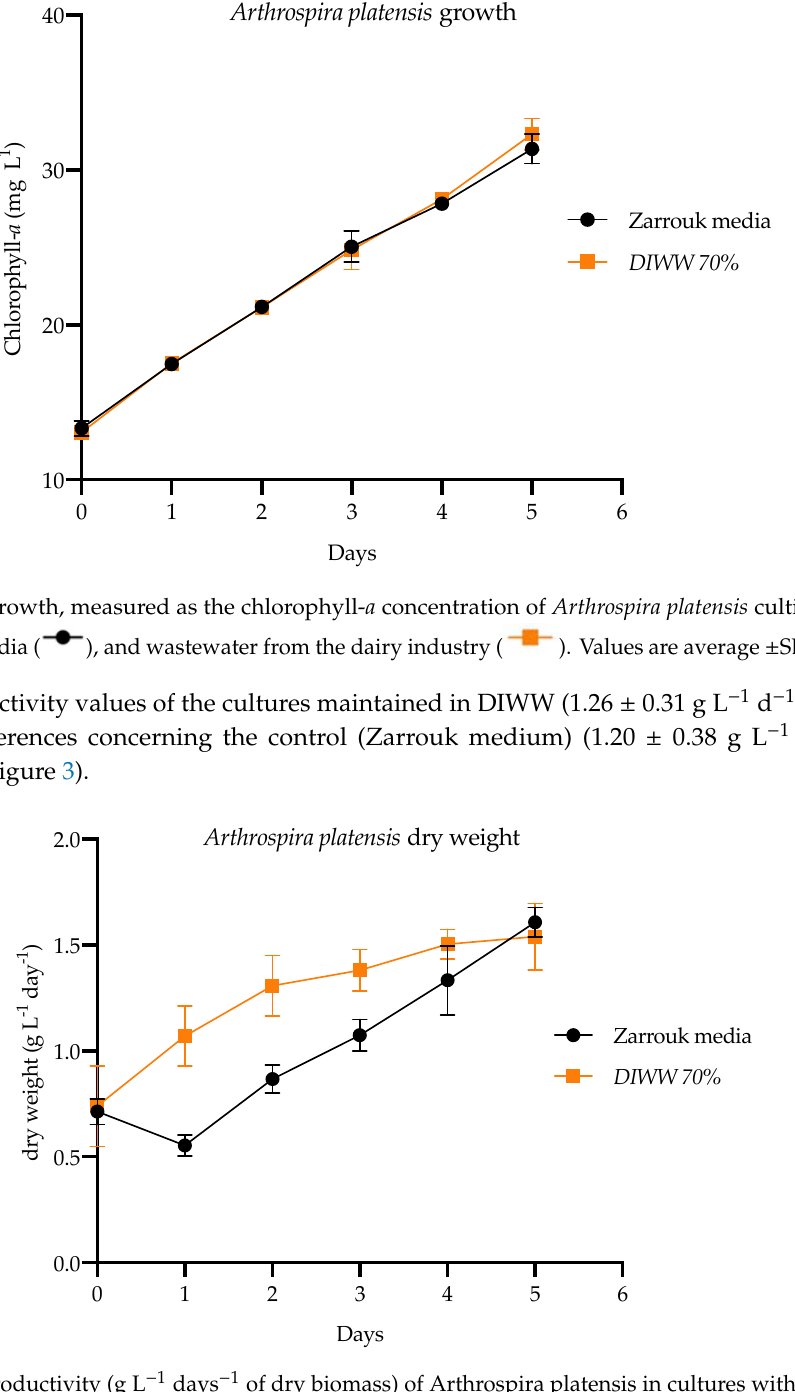
Figure 3. Productivity (g L − 1 days − 1 of dry biomass) of Arthrospira platensis in cultures with Zarrouk medium ( ), and with wastewater from a dairy industry ( ). Values are average ± SD ( n = 3).